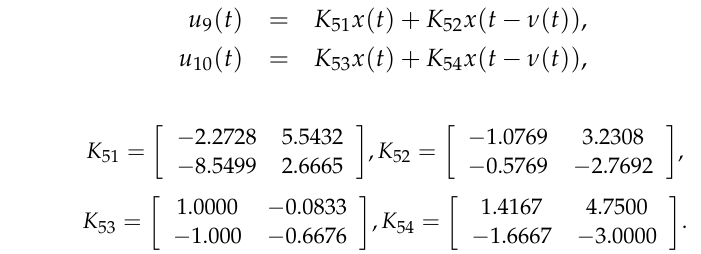
The eigenvalues of the closed-loop system are − 0.7734 + 1.7250 i and − 0.7734 − 1.7250 i . Under the controllers u 9 ( t ) and u 10 ( t ) , the system state trajectories are shown in Figure 7.